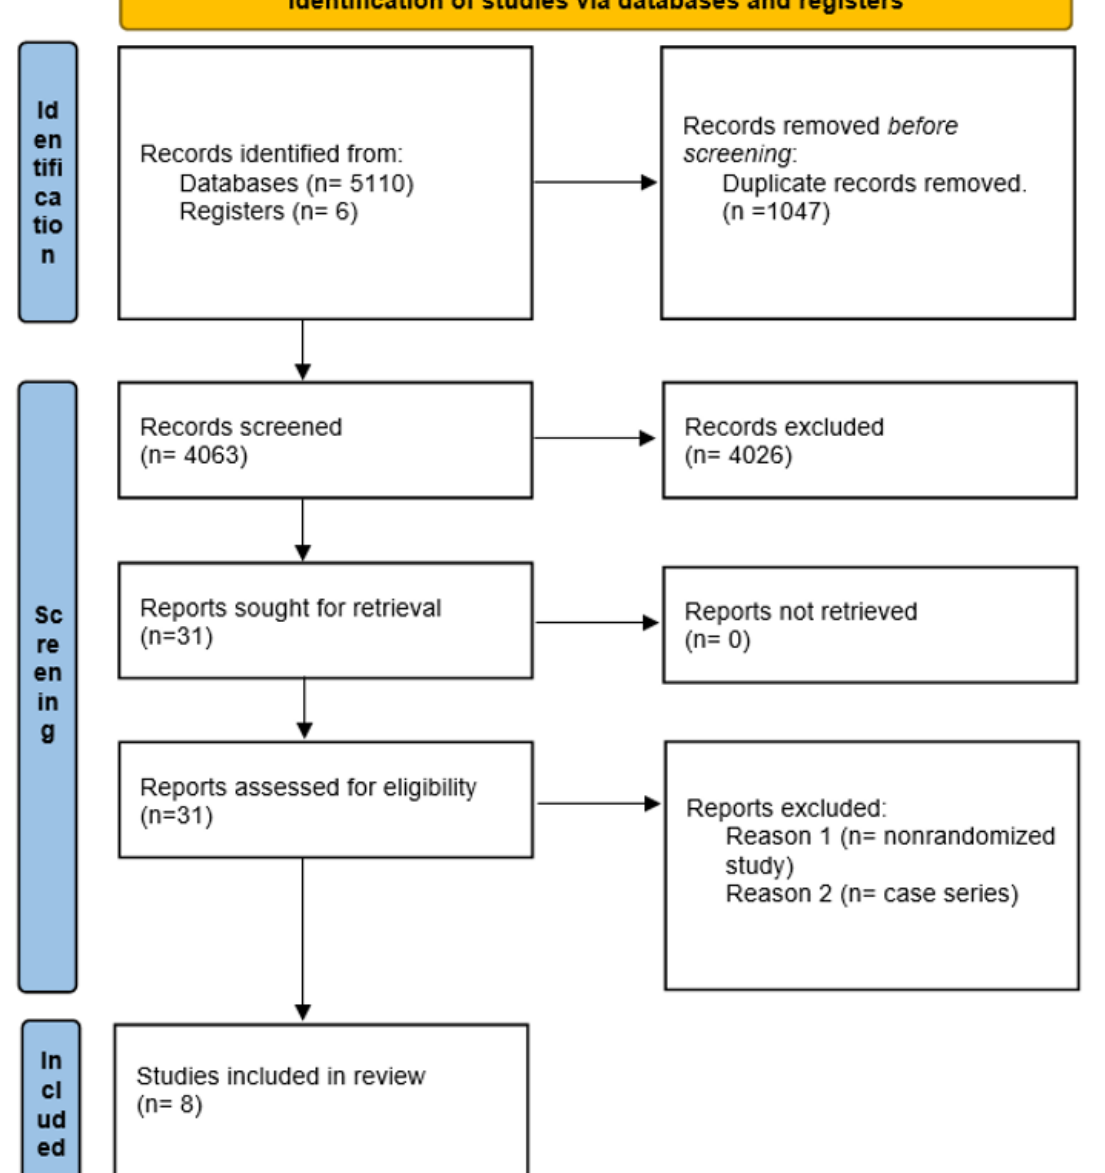
Figure 1. PRISMA 2020 flow diagram for systematic review.